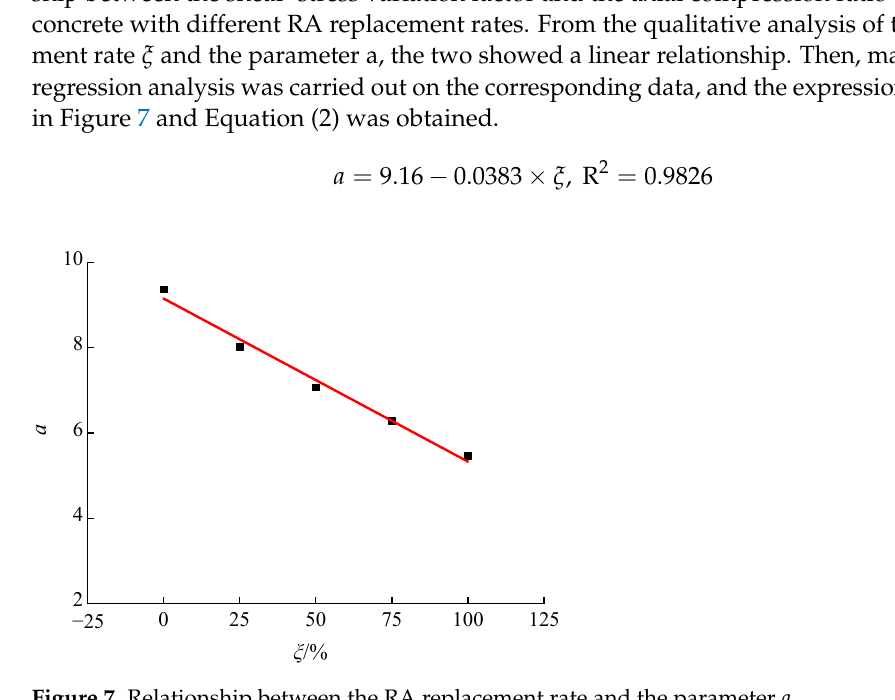
Figure 7. Relationship between the RA replacement rate and the parameter a .